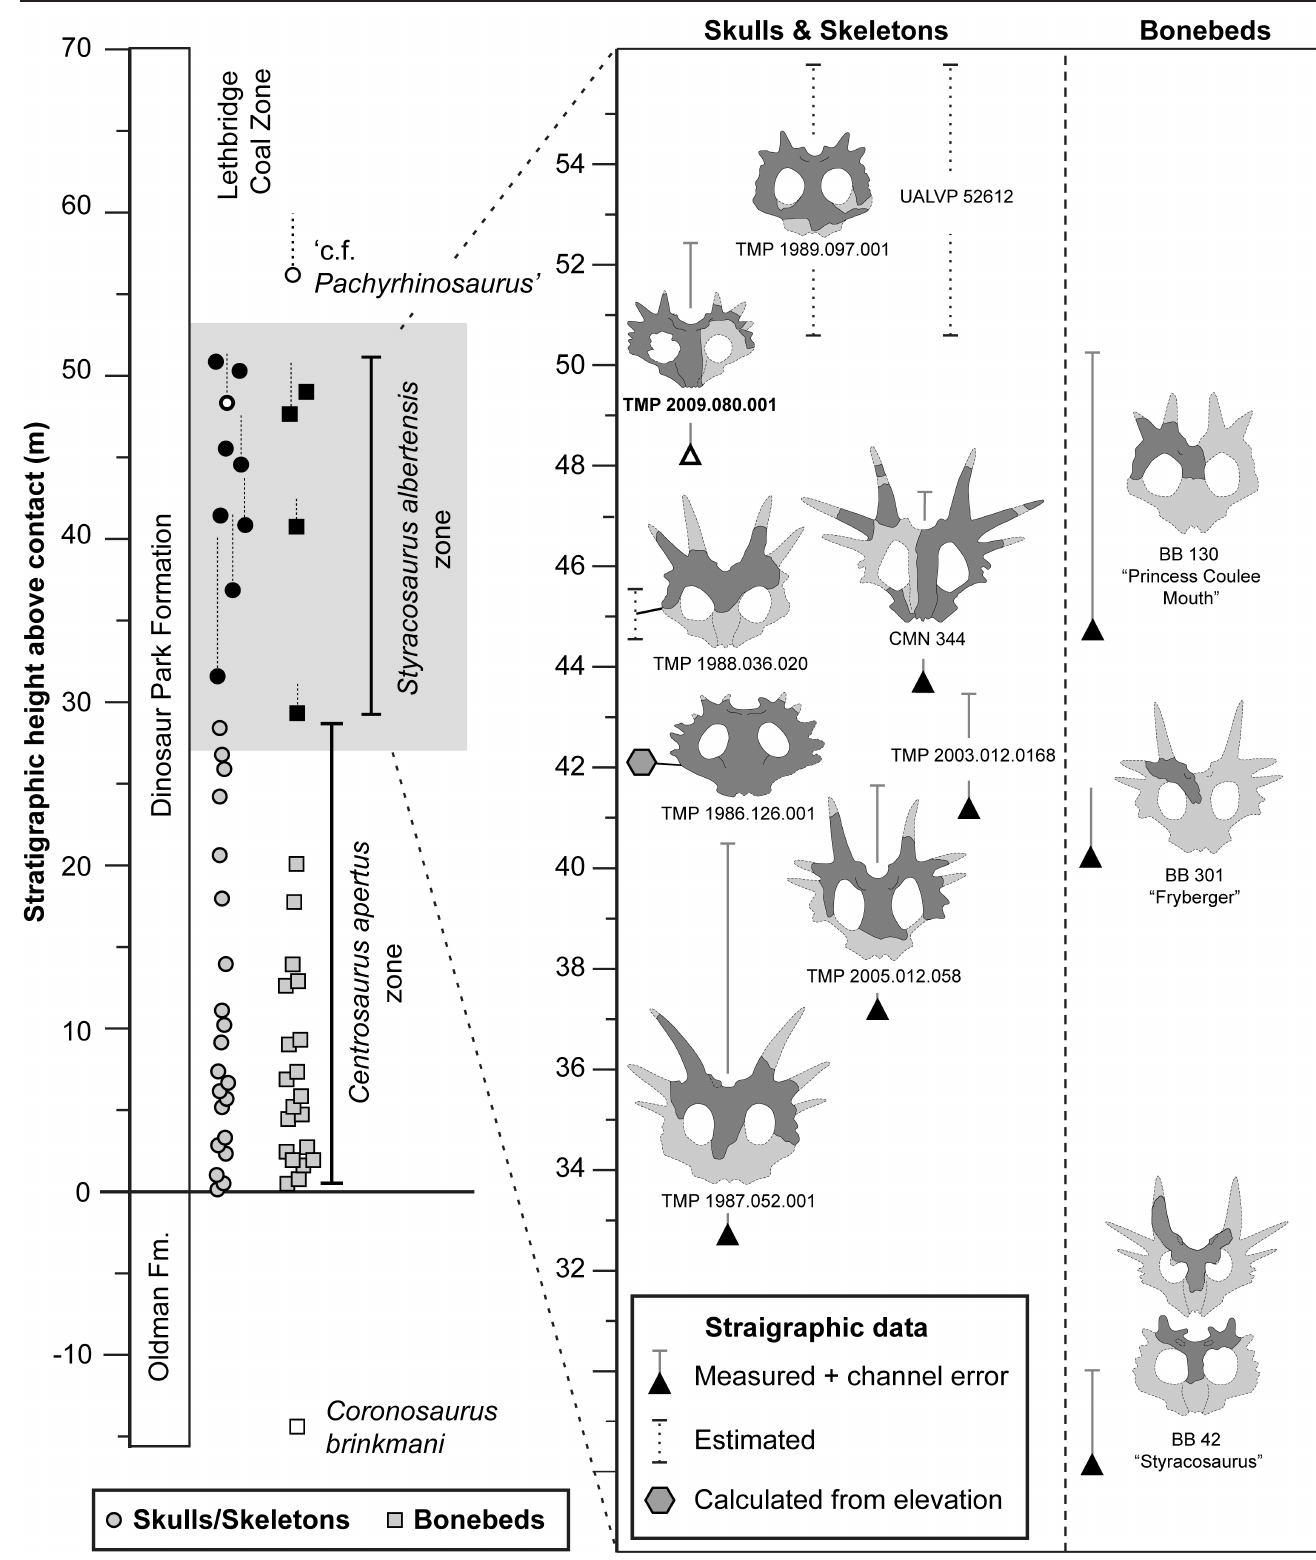
Figure 2. Stratigraphic position of Styracosaurus albertensis specimens within the Dinosaur Park Formation (Campanian) of Alberta, including both bonebeds and isolated skulls and skeletons. The column on the left shows the stratigraphic position of significant centrosaurine specimens, while the inset on the right highlights the parietal morphology of individual Styracosaurus specimens. Bonebeds samples show representative diagnostic specimen only (bottom to top: TMP 1999.055.0005, 1984.093.0001, 2016.015.0005, 2016.012.0029). Stratigraphic position is based on height above the Dinosaur Park/Oldman forma- tion contact. Stratigraphic data derived from Brown (2013). Hollow circle and triangle indicate TMP